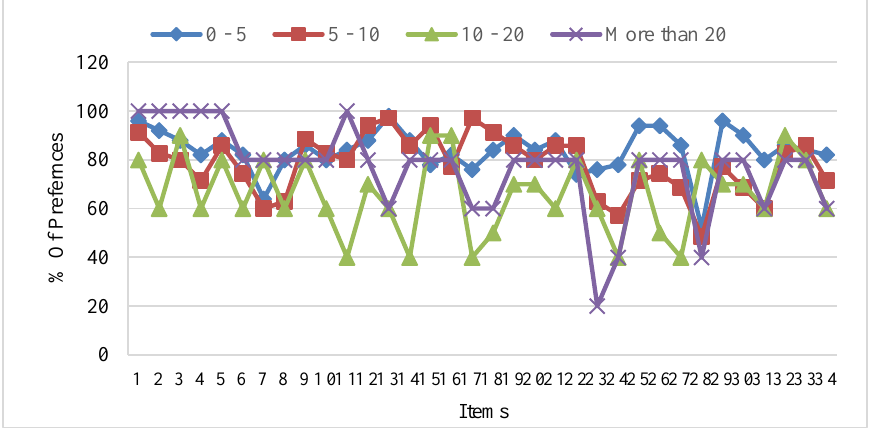
Fig. 4. Preferences of the different items related to the evaluation of the training course in online EP by years of teaching